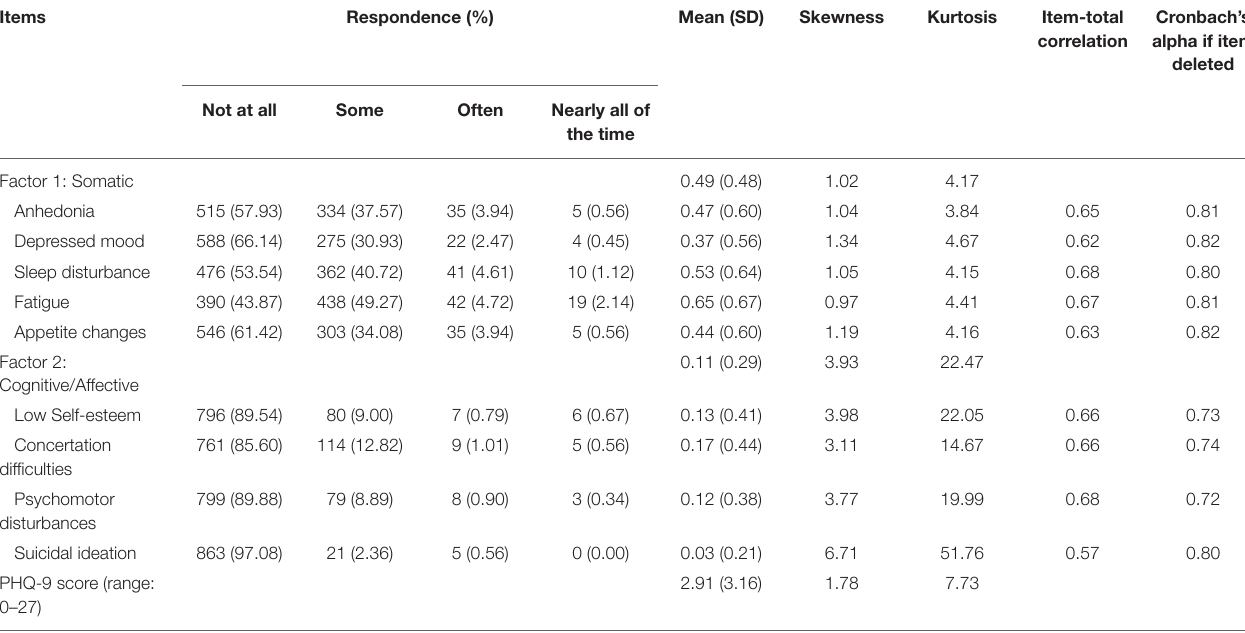
FIGURE 2 | Evaluated Patient Health Questionnaire (PHQ-9) factor structures. Model 1: One-factor PHQ9 model (Chi-Square = 749.019; df = 27; TLI = 0.697; CFI = 0.773; RMSEA (90%CI) = 0.174 (0.163–0.184); SRMR = 0.102; p -value ≤ 0.001; AIC = 8371.595; BIC = 8500.928); Model 2: two-correlated factor PHQ9 model (Chi-Square = 152.183; df = 26; TLI = 0.945; CFI = 0.960; RMSEA (90%CI) = 0.074 (0.063–0.086); SRMR = 0.043; p -value ≤ 0.001; AIC = 7776.759; BIC = 7910.882). df, degrees of freedom; TLI, Tucker-Lewis Index; CFI, comparative fit index; RMSEA, root-mean-square error of approximation; RMSEA 90% CI: 90% confidence interval for RMSEA; SRMR: standardized root-mean-square residual. TABLE 4 | Basic descriptions and reliability of Patient Health Questionnaire (PHQ-9)